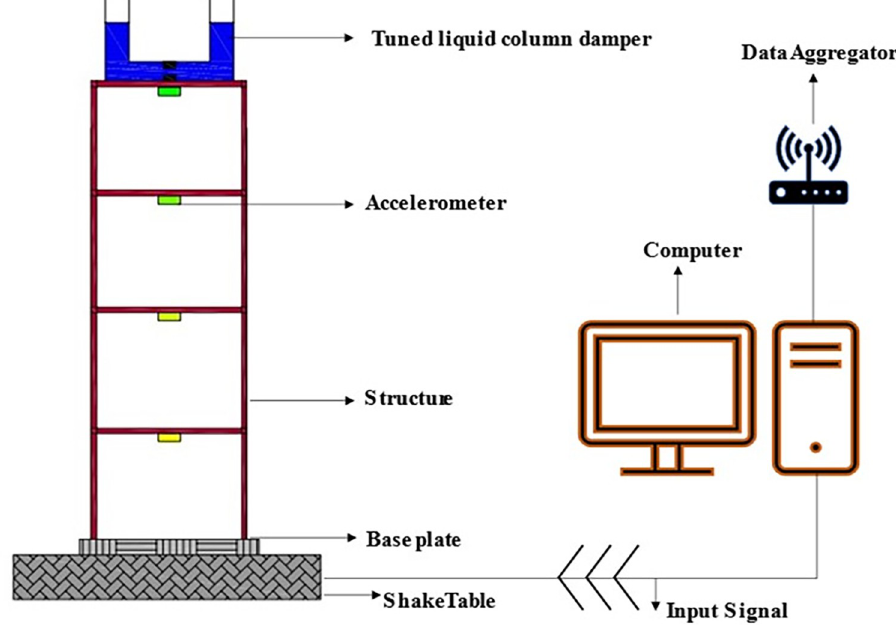
Fig 5. A schematic view of the experimental setup shows the MDOF structure equipped with